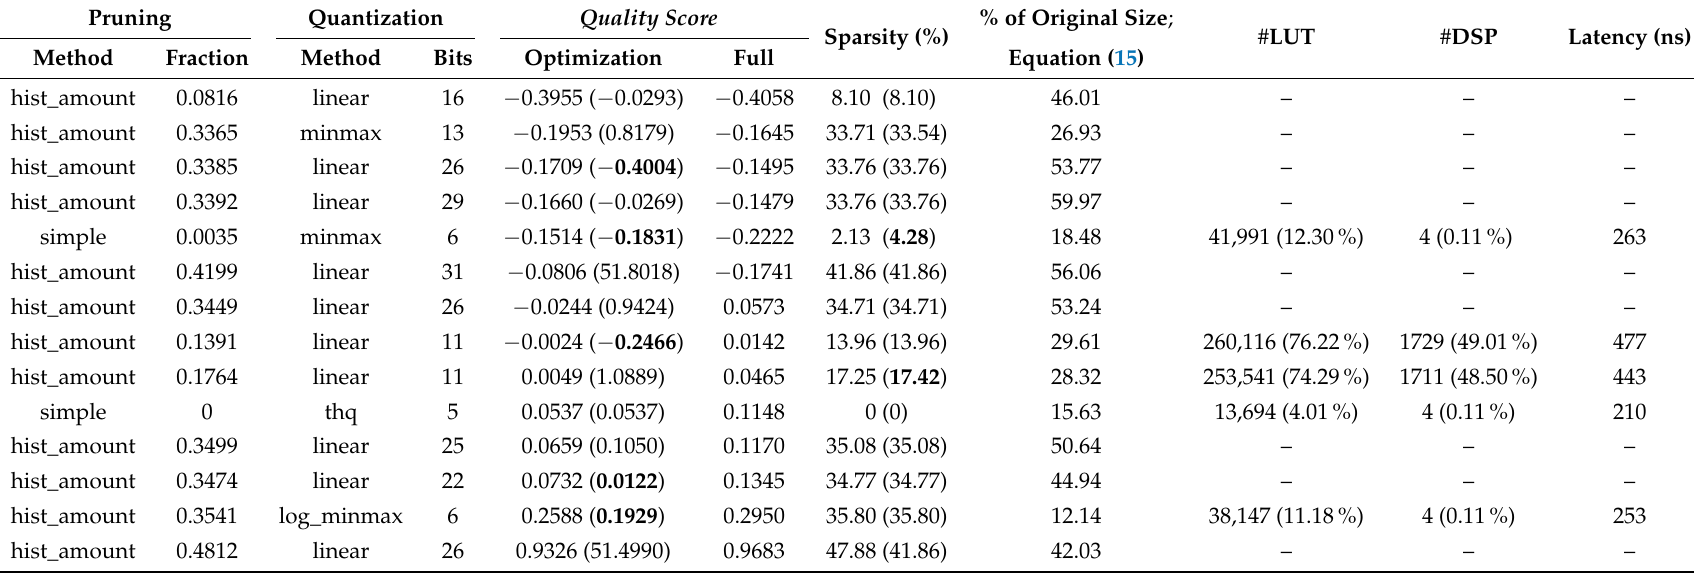
Table 5. [LHC] Results for pruned and quantized model trained (and retrained) on continuous data. In ‘ quality score ’ and ‘sparsity’ columns, values in parentheses indicate results obtained when using model retraining (see Section 3.3.4), with results better than with no retraining marked in bold. Pauses indicate results, for which the resources consumption exceeded the XCZU15EG FPGA capacity. Percentages in the ‘#LUT’ and ‘#DSP’ refer to the overall resources available on the